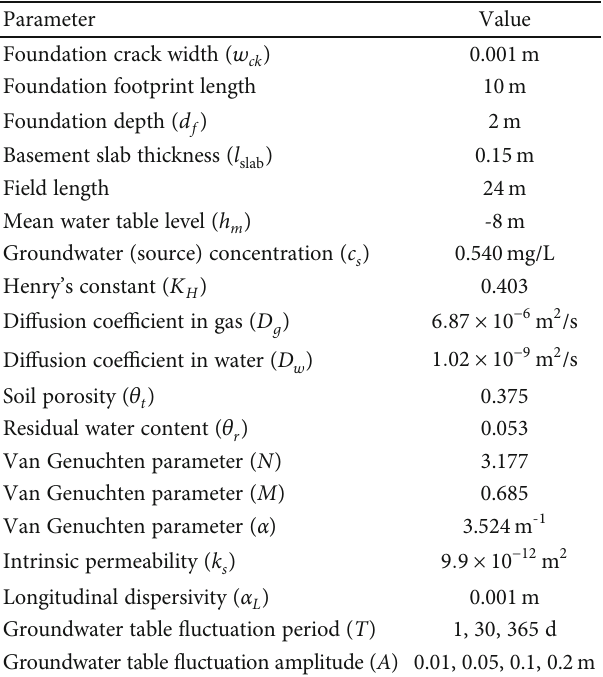
Figure 1: The schematic of the conceptual model. Table 1: Parameters inputted in the